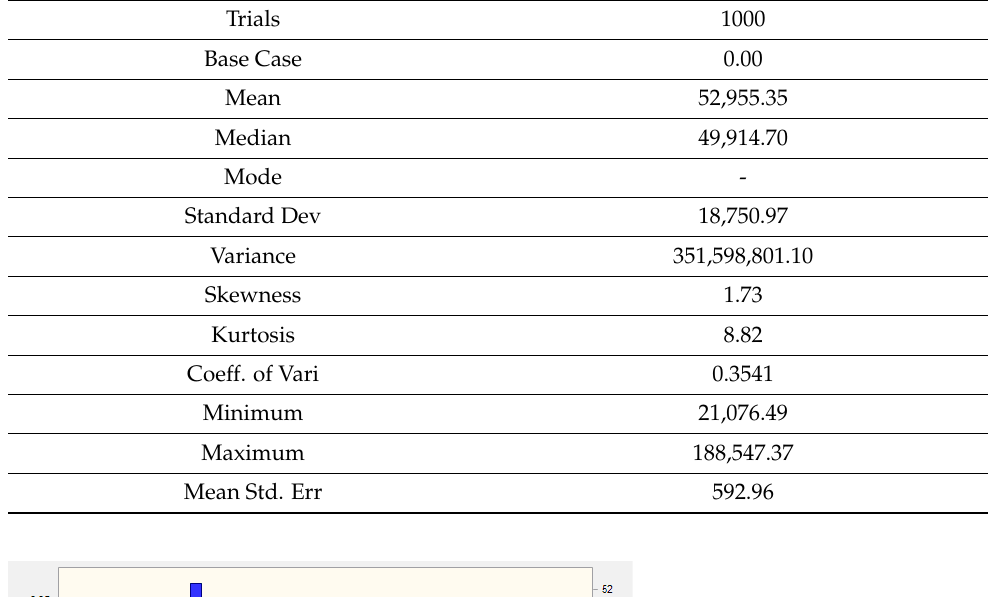
Table 11. Descriptive statistics of the probability distribution of the present value of incomes from the accommodation rental facilities for 10 years in the region of Liptov.